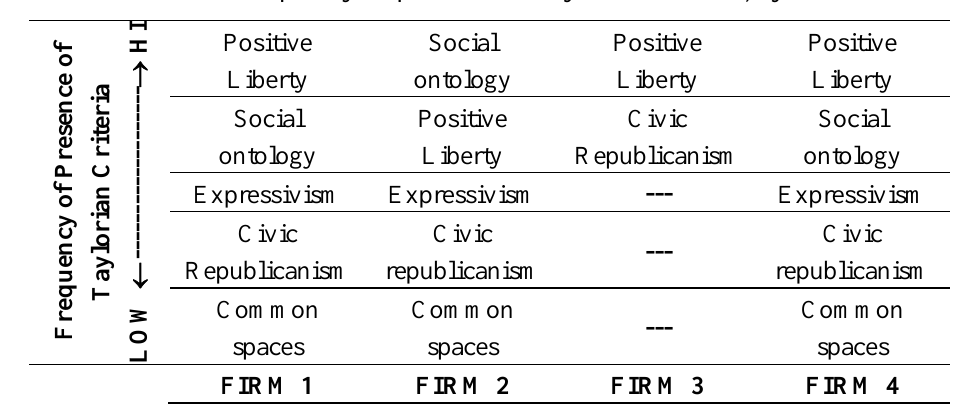
Table 4. Frequency of presence of taylorian criteria, by